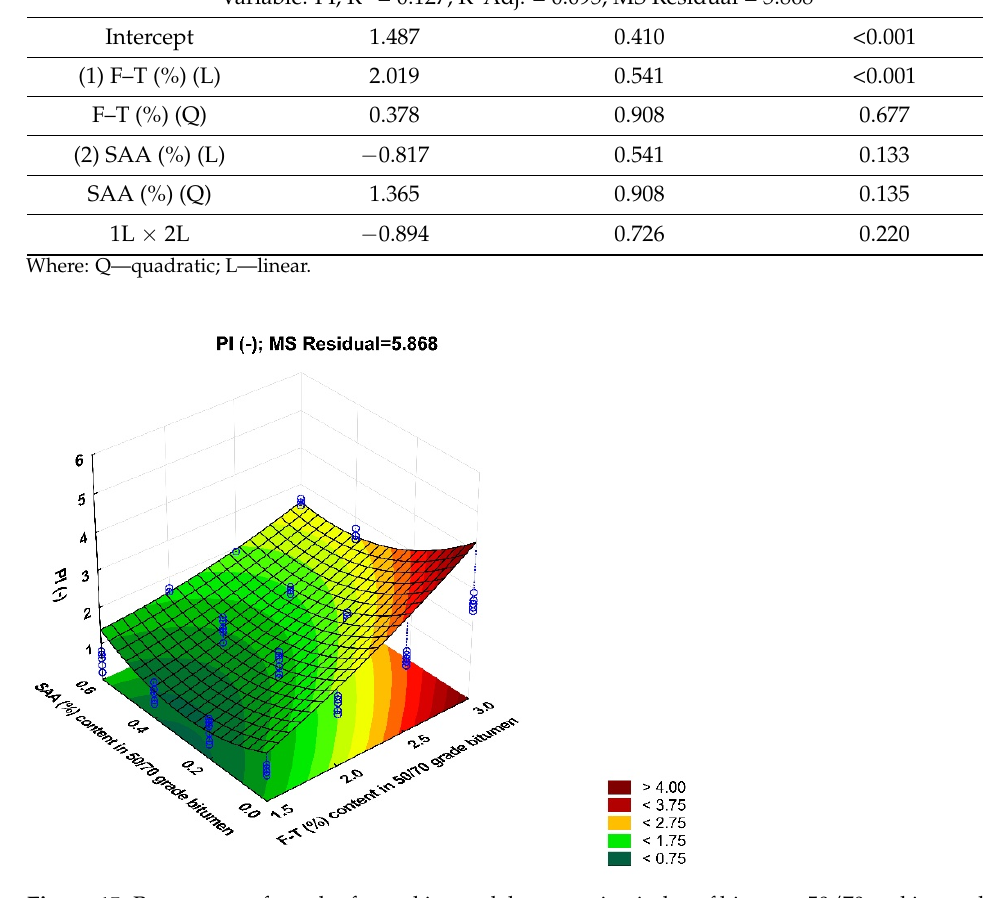
Figure 15. Response surface plot for penetration index of bitumen 50/70 and its model.